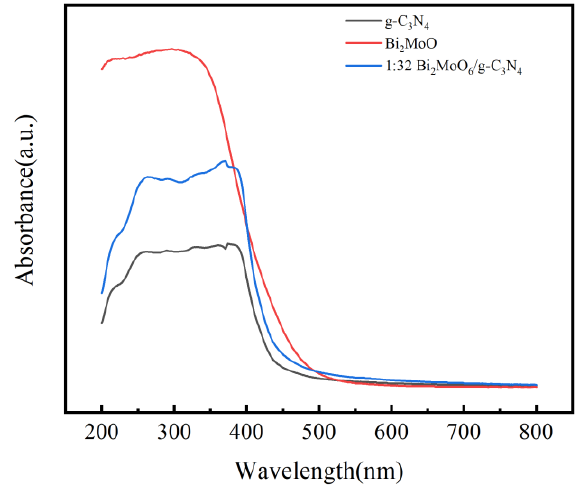
Figure 5. UV–vis spectra a of g-C 3 N 4 , Bi 2 MoO 6 and 1:32 Bi 2 MoO 6 /g-C 3 N 4 Figure 5. UV – vis spectra a of g-C 3 N 4 , Bi 2 MoO 6 and 1:32 Bi 2 MoO 6 /g-C 3 N 4 .